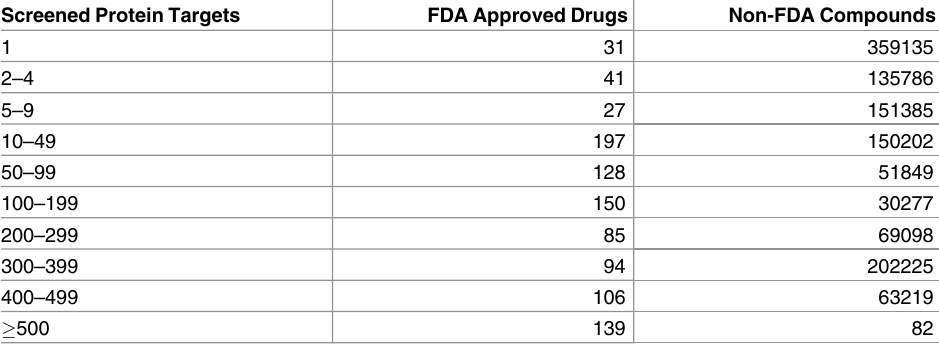
Table 1. Screening frequency of FDA approved and non-FDA compounds against increasing numbers of protein targets. Data is includedfrom all assay experiments in PubChemBioAssay annotated with one clearly definedprotein target, and reportingan active score for at least one small molecule.Multipleassays againstthe same target are countedonly once. Screened Protein